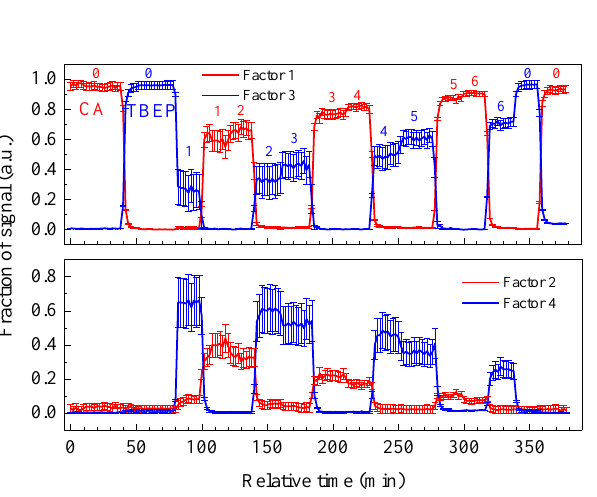
Figure 2. Averaged mass spectra of the four-factor solution for in- dividually oxidized TBEP-AN and CA-AN particles. The red lines indicate the characteristic fragments of CA, while the blue lines are those for TBEP.